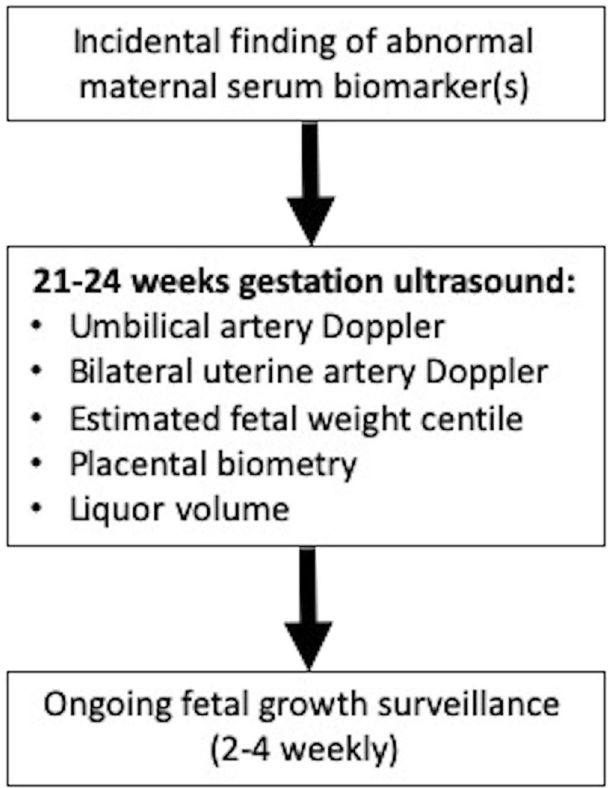
Figure 5. Manchester University NHS Foundation Trust (MFT) Placenta Clinic referral